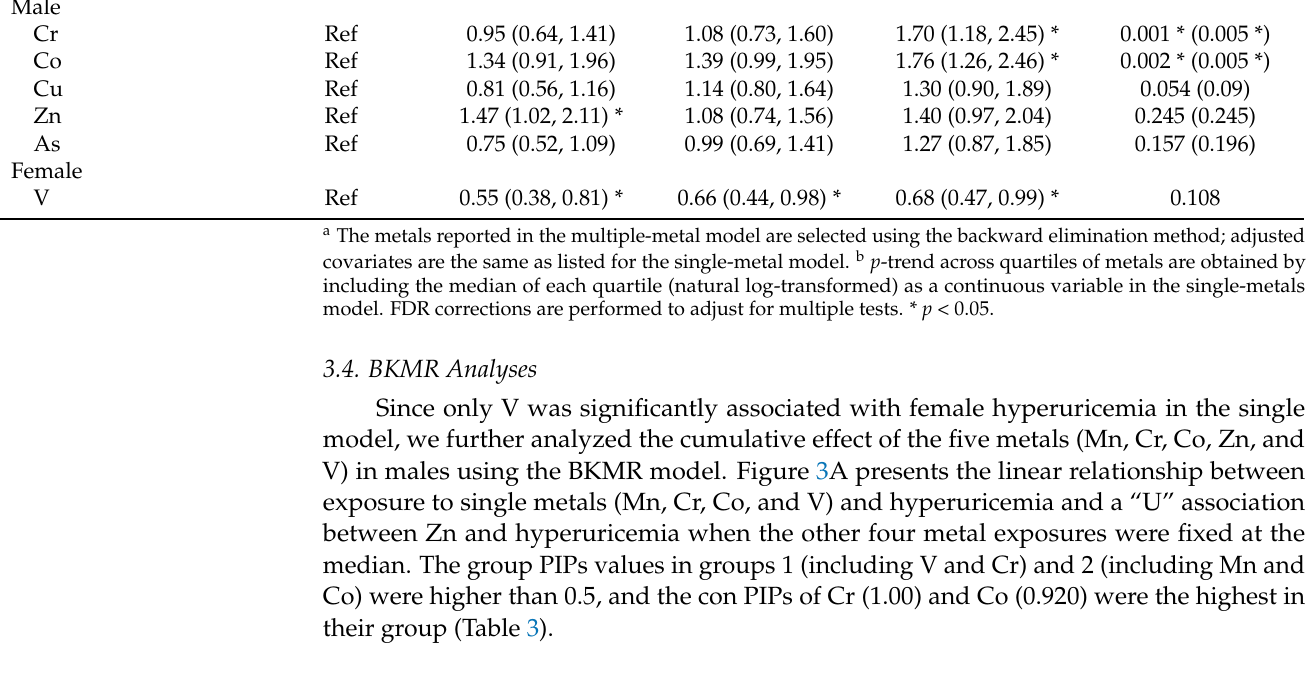
Table 2. Multiple-metal logistic regression model for the associations of blood metal quartiles with hyperuricemia.